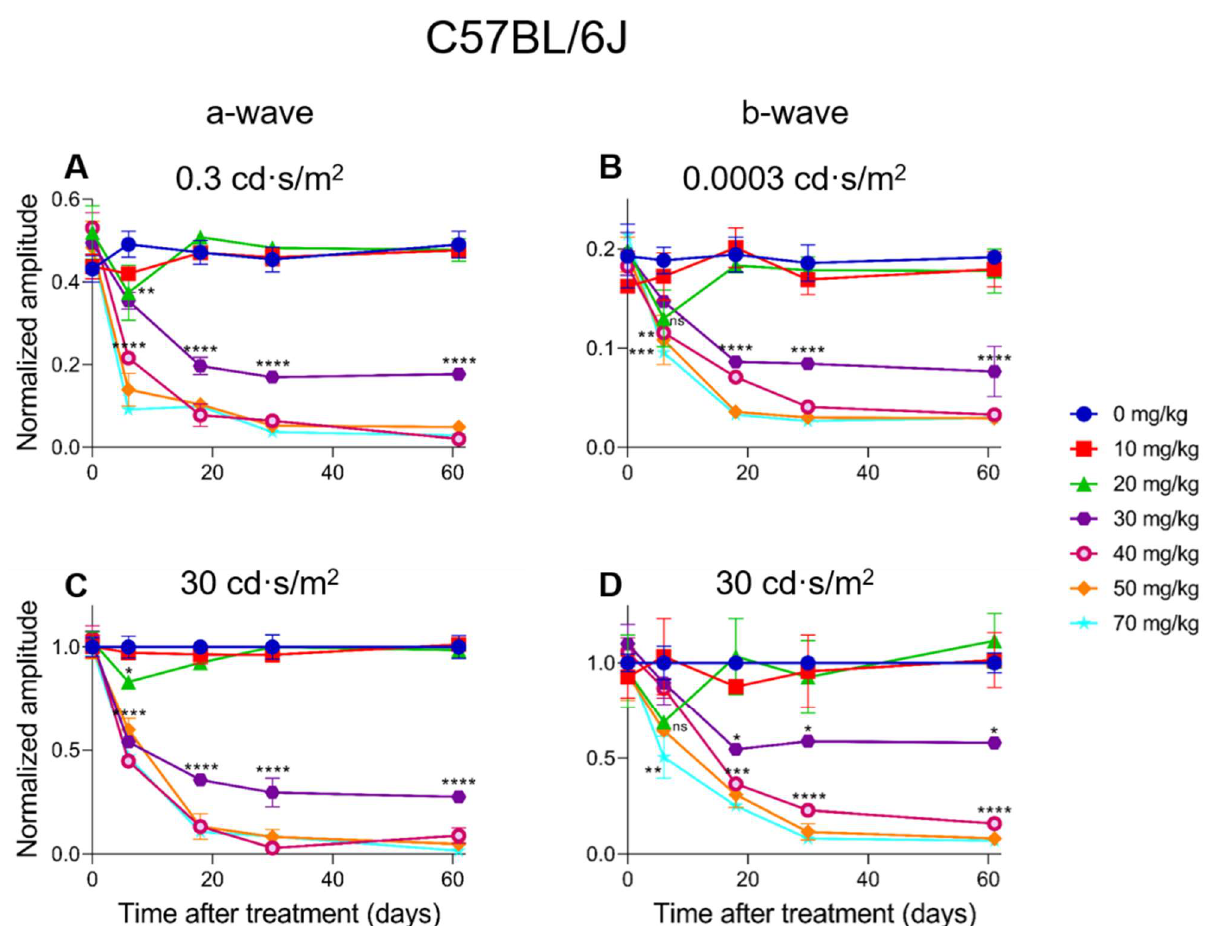
Figure 6. The normalized a- wave ( A , C ) and b-wave ( B , D ) amplitudes are plotted versus the time after treatment for all the treatment groups in C57BL/6J mice ( n = 4 per group). The amplitudes are shown measured at 0.3 cd∙s/m 2 ( A ) and 30 cd∙s/m 2 ( C ) (a-wave) and 0.0003 cd∙s/m 2 ( B ) and 30 cd∙s/m 2 ( D ) (b-wave) including the standard deviations. No significant effect was observed for the 10 mg/kg group compared to the control. Although not significant for the b-wave, a temporary effect, and significant for the a-wave amplitude, was seen for the 20 mg/kg treatment group ( A , C ). This effect was not observed anymore later in the experiment. From seven-days post-injection onwards, signif- icant decreased responses were observed for all the other treatment groups. The effects of the 30 mg/kg group was moderate and more prominently visible in the a-wave amplitude compared to the b-wave amplitude for both light intensities. Tremendous effects were seen for the higher treat- ment groups (40, 50, and 70 mg/kg). From three-weeks post-injection onwards, almost non-detecta- ble a-wave amplitudes were observed and extremely decreased b-wave amplitudes. ns : not signifi- cant, *: p ≤ 0.05, **: p ≤ 0.01, ***: p ≤ 0.001, and ****: p ≤ 0.0001.